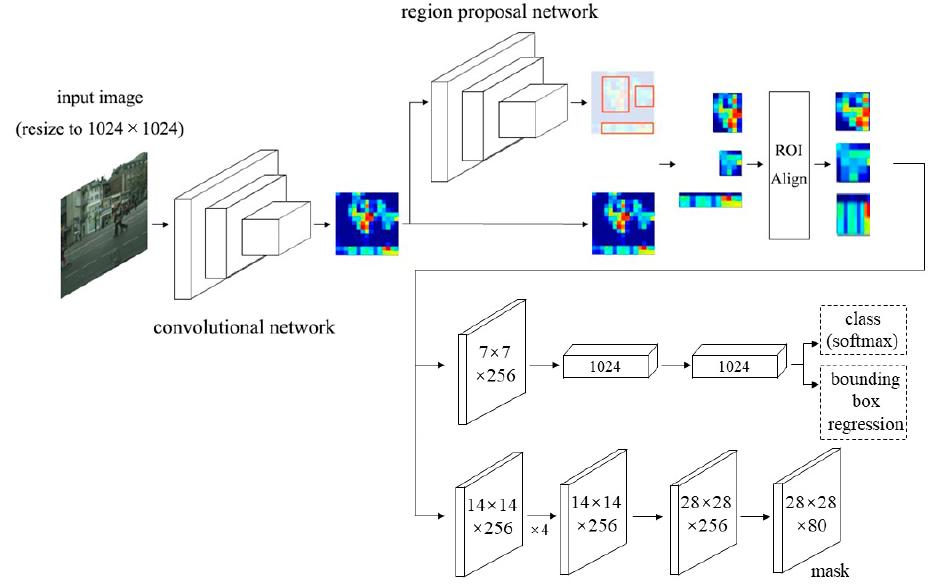
Figure 3. The pipeline of Mask R-CNN. ROIAlign and mask head are the key improvement points of Mask R-CNN over Faster R-CNN .